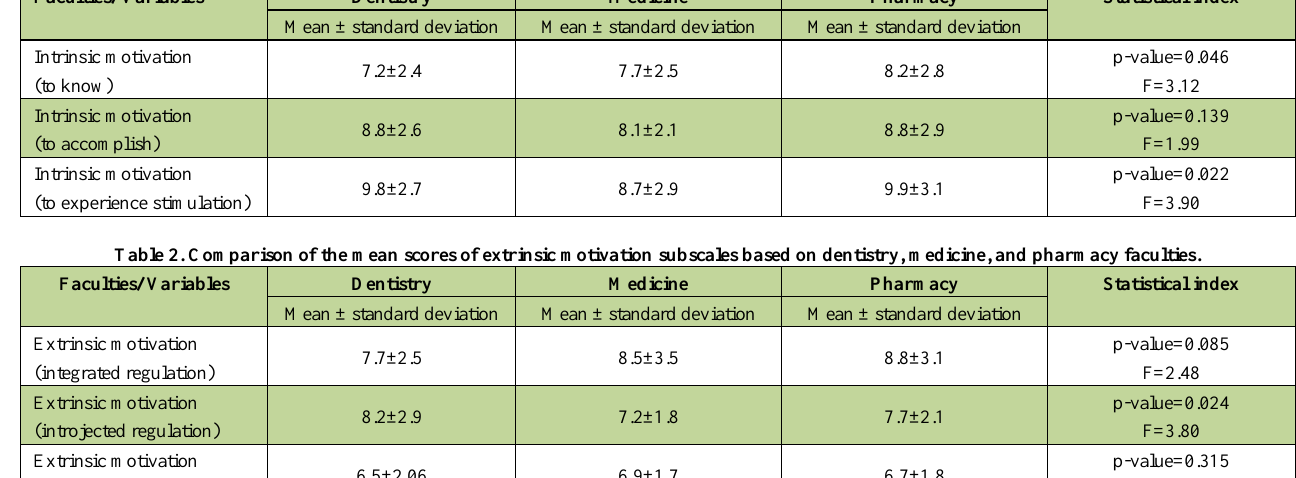
Table 1. Comparison of the mean scores of intrinsic motivation subscales based on dentistry, medicine, and pharmacy faculties. Faculties/ Variables